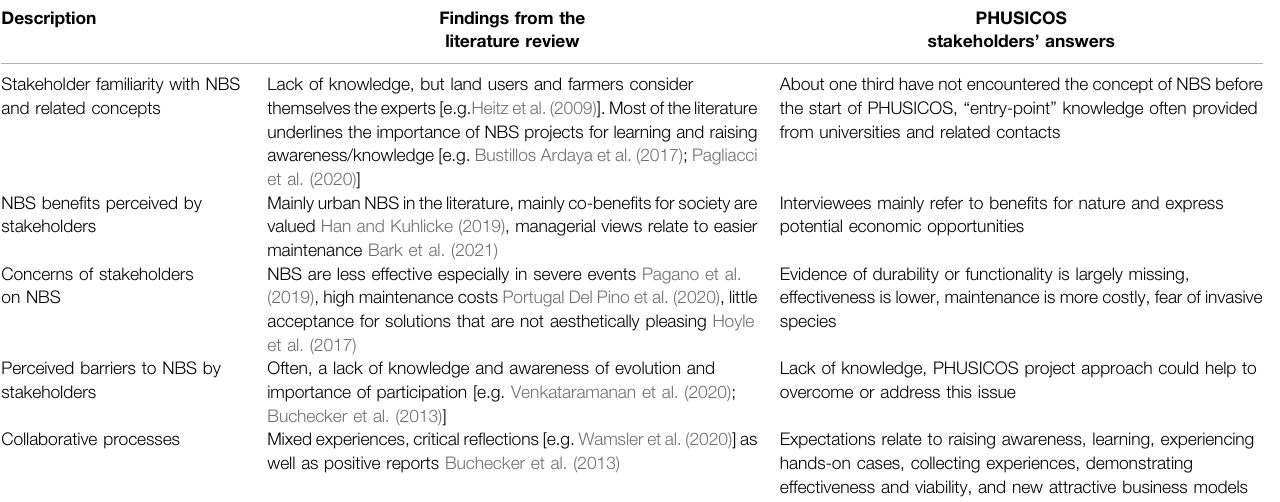
TABLE 2 | : Comparison between literature fi ndings and interviews with